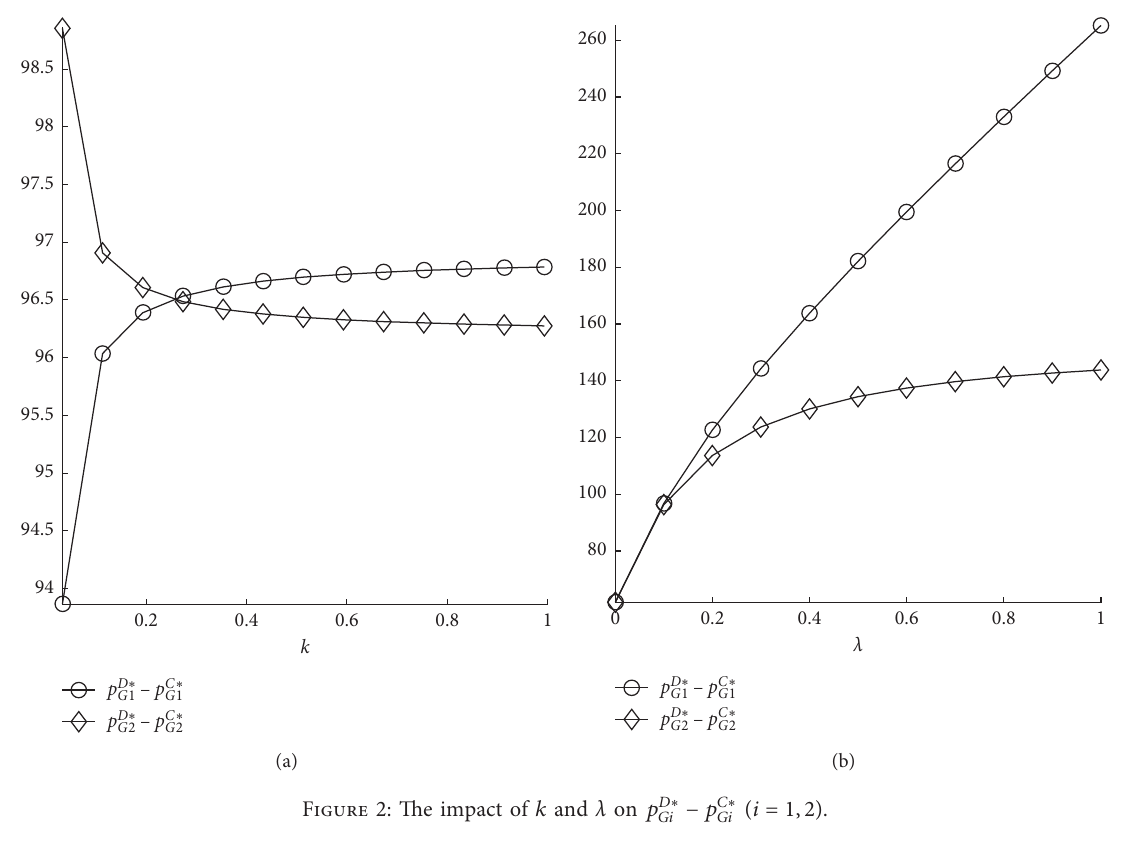
Figure 2: The impact of k and λ on p D ∗